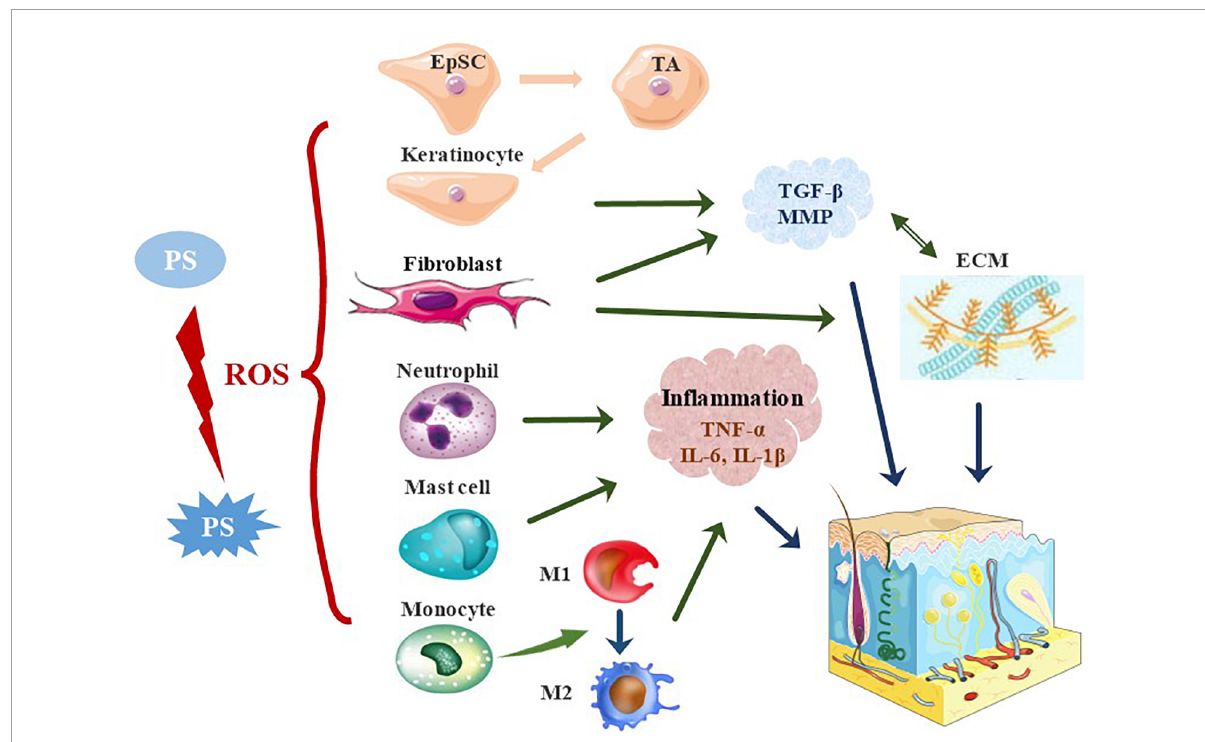
FIGURE2 The effects of photosensitizer-based therapies on skin cells. In PDT, PS is activated to generate ROS, which promotes wound healing by stimulating skin resident cells and recruiting immune cells. PDT activates quiescent EpSCs to divide into proliferative TA cells, which promote re-epithelialization by enhancing their proliferation and migration. Besides, PDT stimulates the proliferation of keratinocytes and fibroblasts, and increases the secretion of TGF- β and MMP, thereby stimulating the production of collagen and elastin. PDT alters the local immune state and induces acute inflammatory responses in the early stages of trauma. PDT significantly affects the activation and migration of neutrophils. The neutrophil response is switched to that of monocyte-macrophages in the early stages of wound repair. The pro-inflammatory M1 phenotype is adopted in the early stages of injury and the anti-inflammatory M2 phenotype in the middle and late stages. PDT induces rapid recruitment of mast cells to further degranulate and release inflammatory molecules. EpSC, epidermal stem cells; TA cells, transient amplifying cells; ECM, extracellular